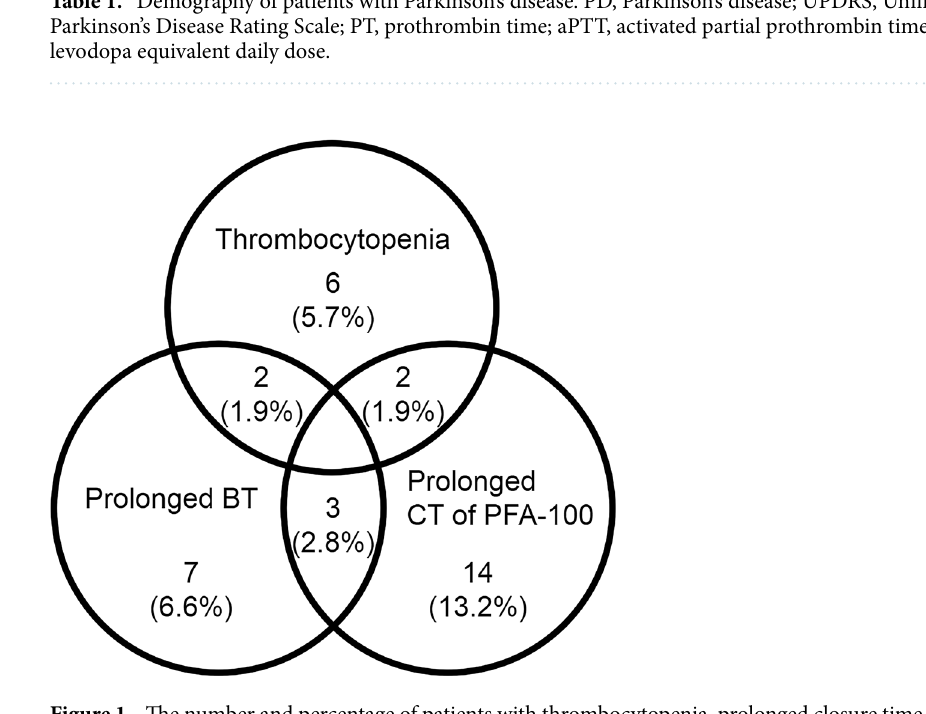
Figure 1. The number and percentage of patients with thrombocytopenia, prolonged closure time of platelet function analyzer 100 (CT of PFA-100), and/or prolonged bleeding time (BT) in 106 patients with Parkinson’s